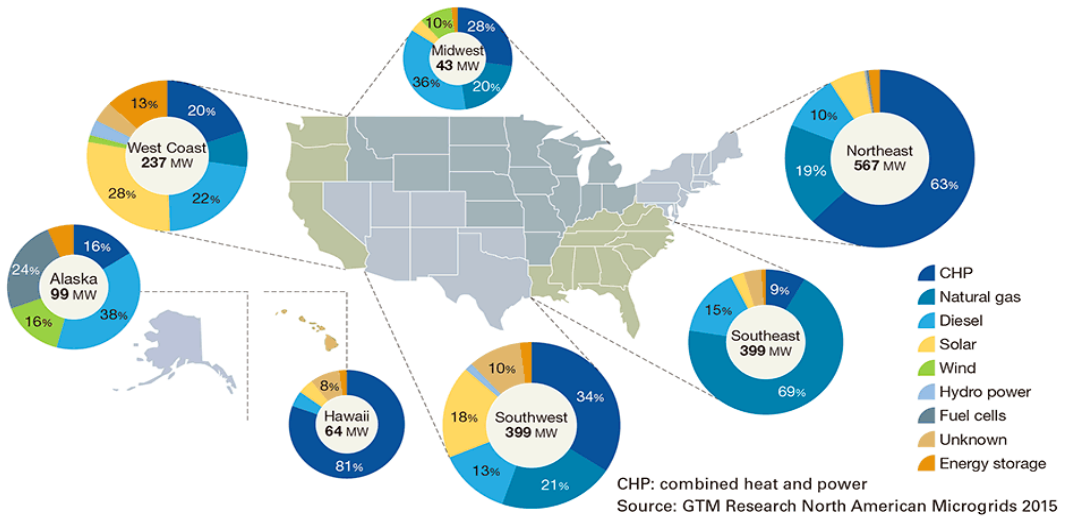
Figure 2. Participation of renewables in microgrid.